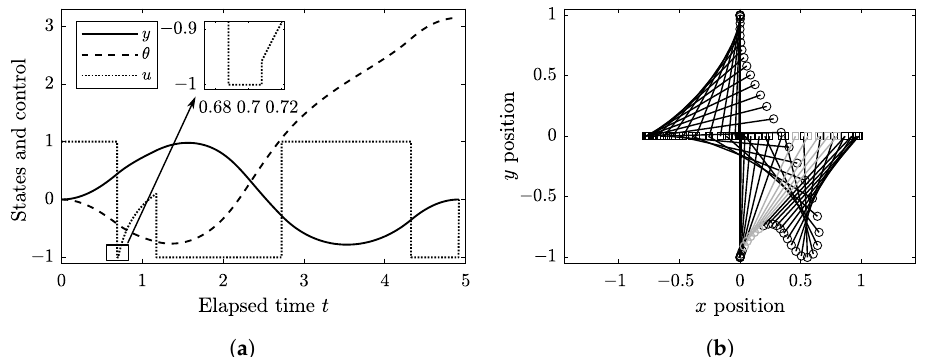
Figure 3. ( a ) Solution with three phases, and ( b ) stroboscopic movie with 50 equally spaced time steps; the gray lines denote the singular